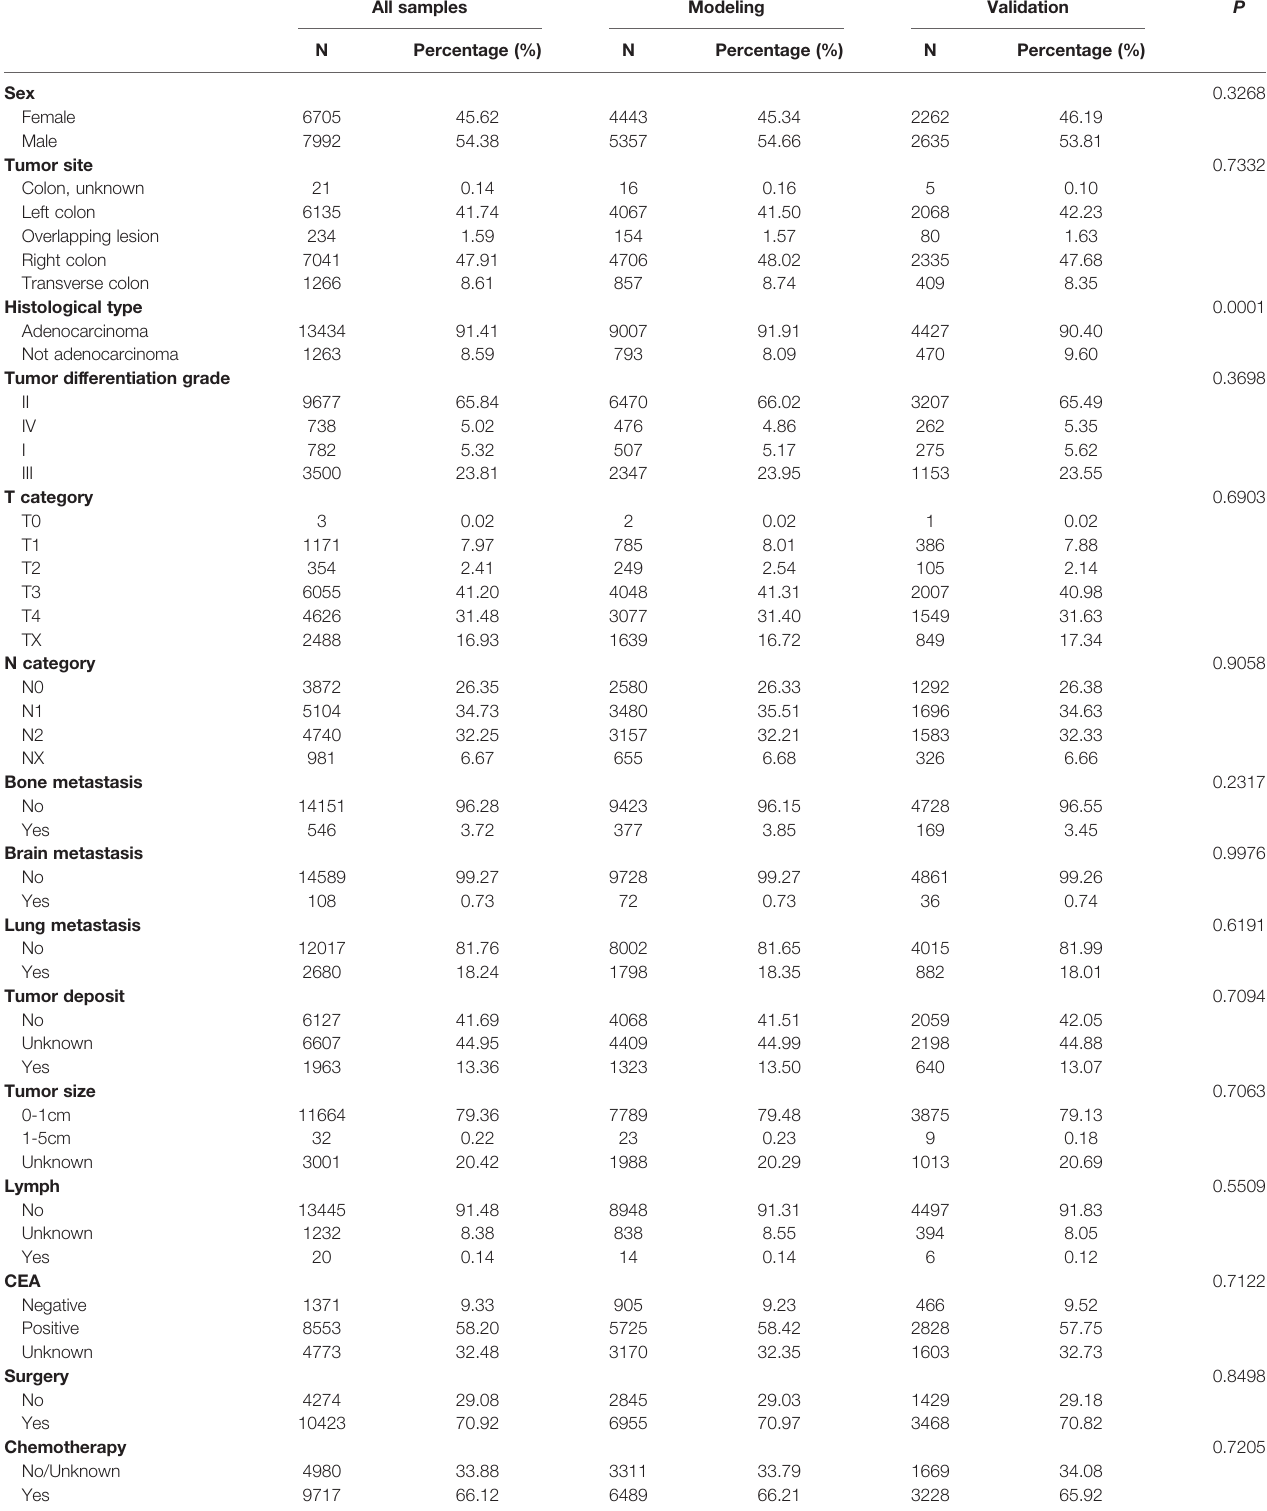
TABLE 1 | The baseline characteristics of enrolled CLM patients. All samples